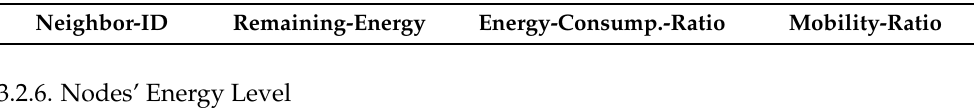
Table 5. Information about